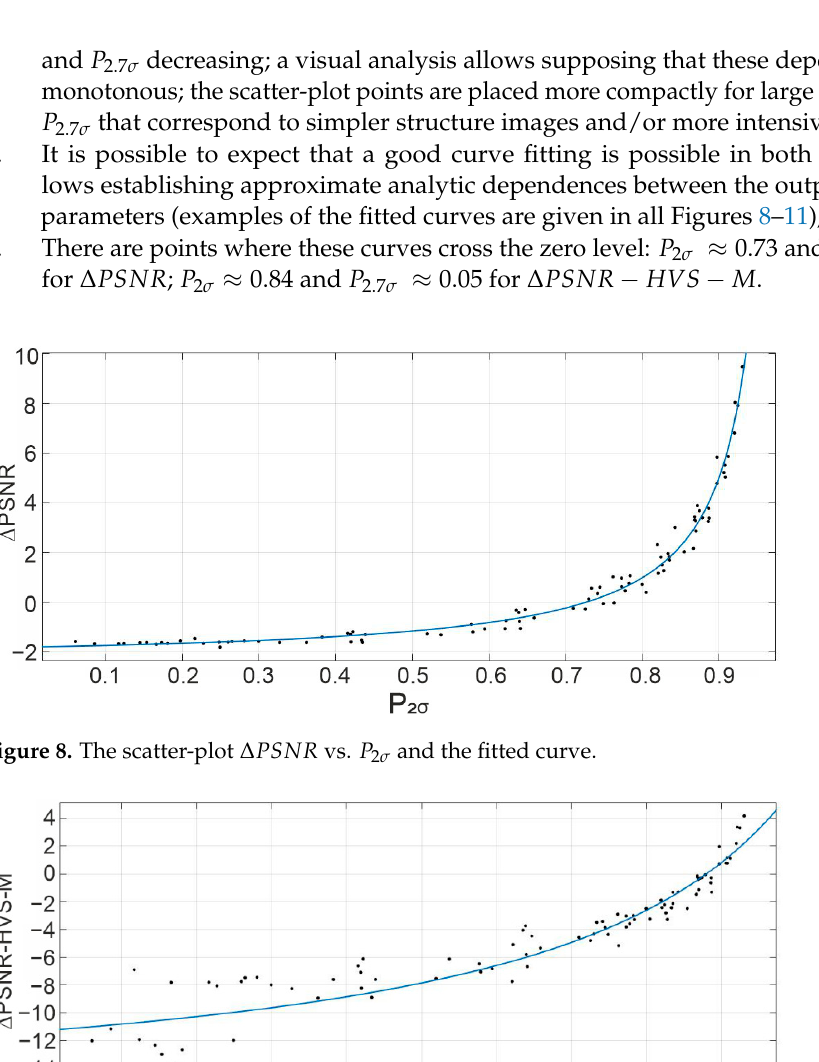
Figure 9. The scatter-plot ∆𝑃𝑆𝑁𝑅 − 𝐻𝑉𝑆 − 𝑀 vs. 𝑃 2𝜎 and the fitted curve.